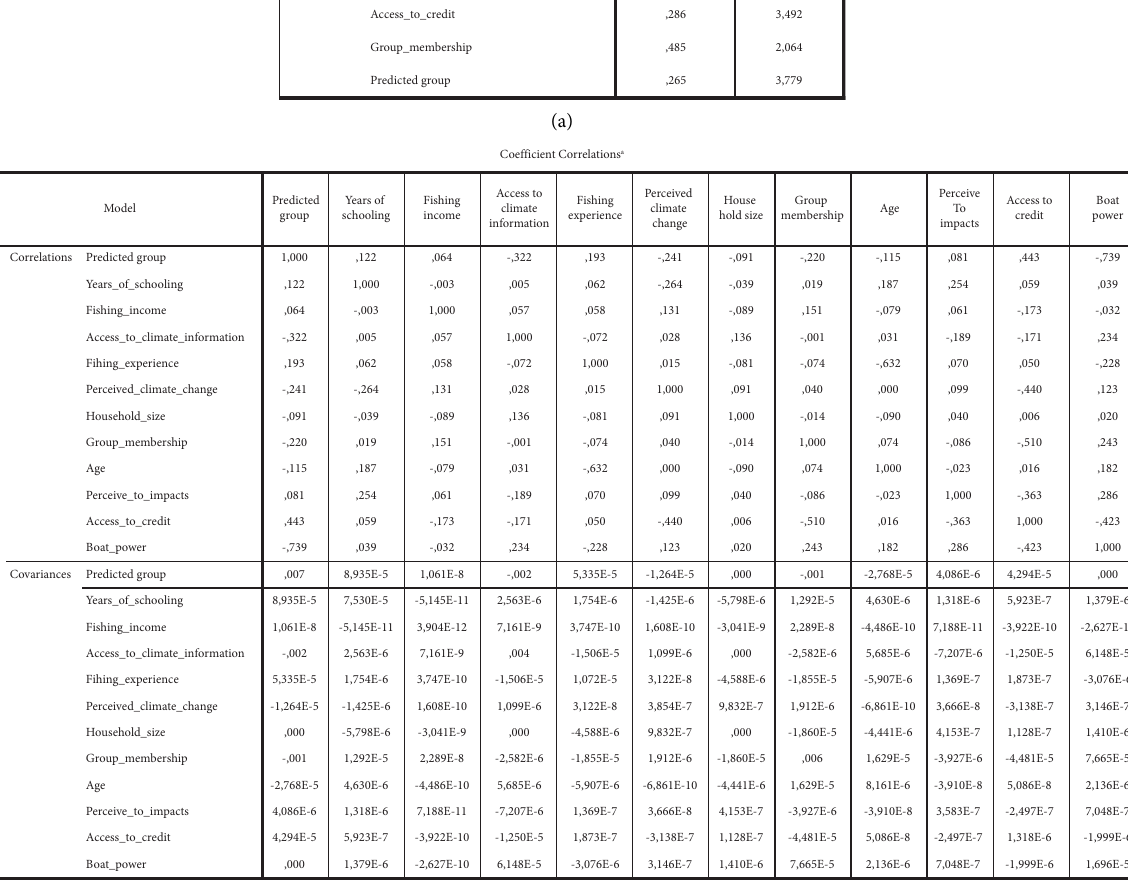
Figure 4: Te result of